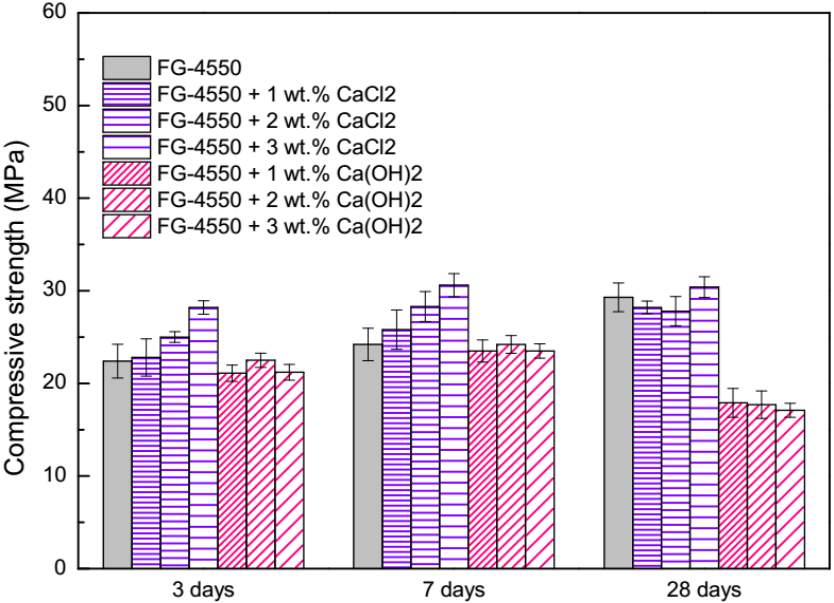
Figure 4. Compressive strength of activated FG-4550 under steam curing conditions.